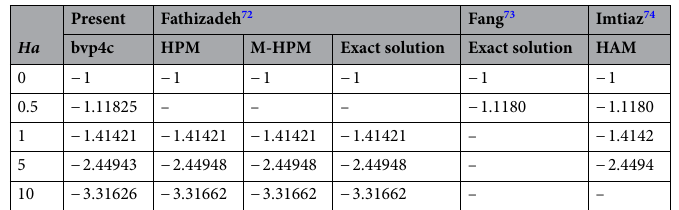
(cid:31) Pr δ d Rd N t N b Q ∗ D f e S c = = = = = = = = = = = with Fathizadeh et al. 72 , Fang et al. 73 , and Imtiaz et al. 74 with the